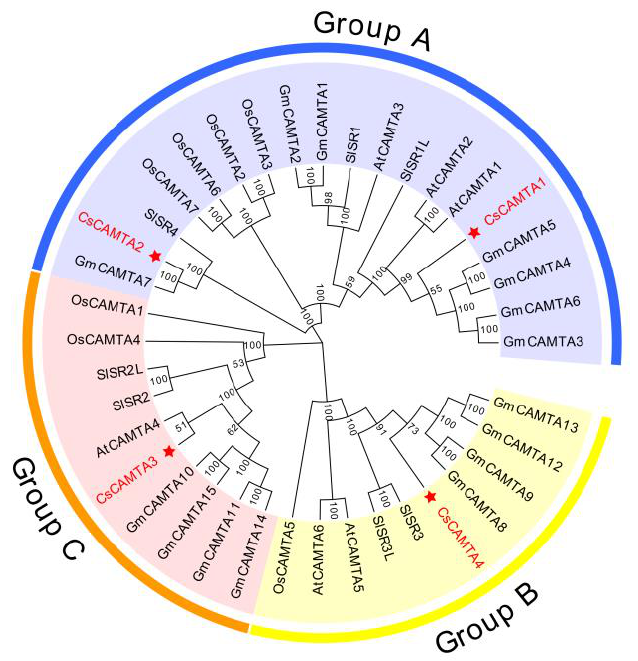
Figure 3. Phylogenetic relationship of the CAMTA homologs in different species. Cucumbers are marked as a red five-pointed star.